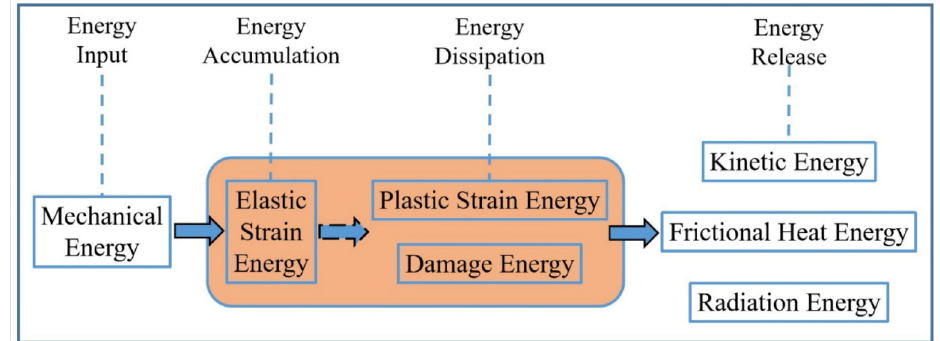
Figure 3. The energy system of the loaded rock.